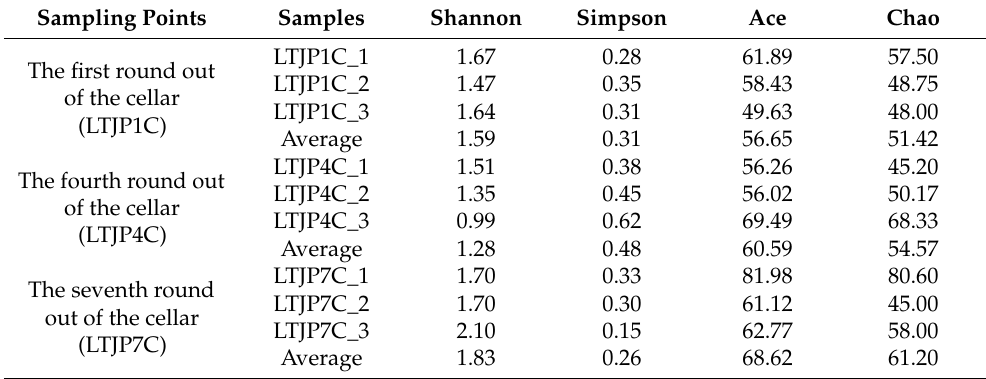
Table 1. Bacterial alpha diversity indices during baijiu